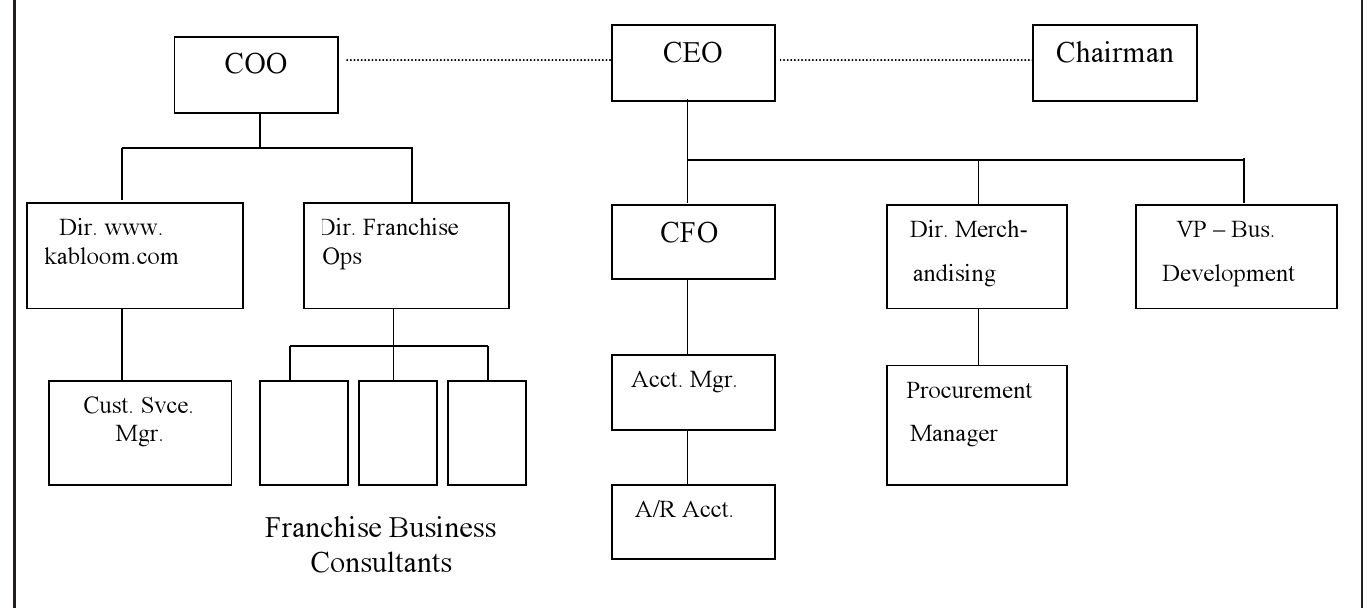
Figure 1. KaBloom Organizational Chart